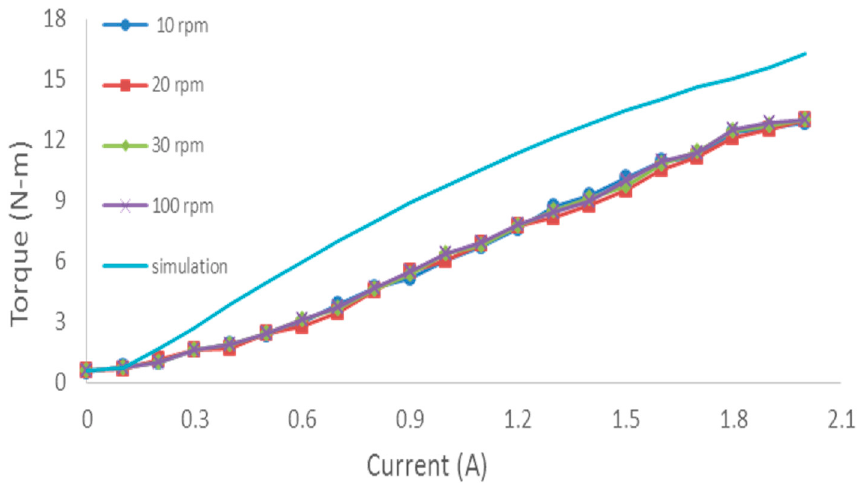
Figure 7. The relationship between resistance torque of the MR brake and current.